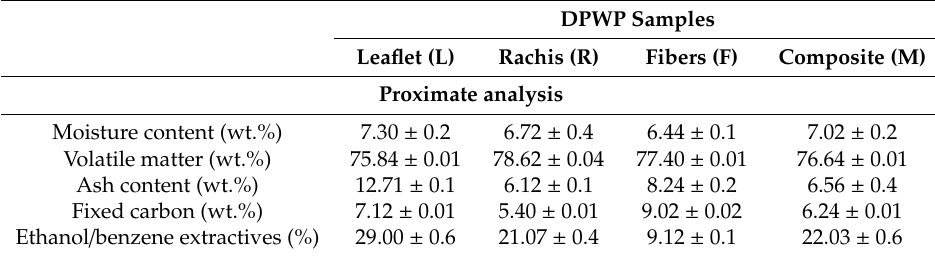
Table 1. Physicochemical analysis of date palm waste parts (DPWP) (dried